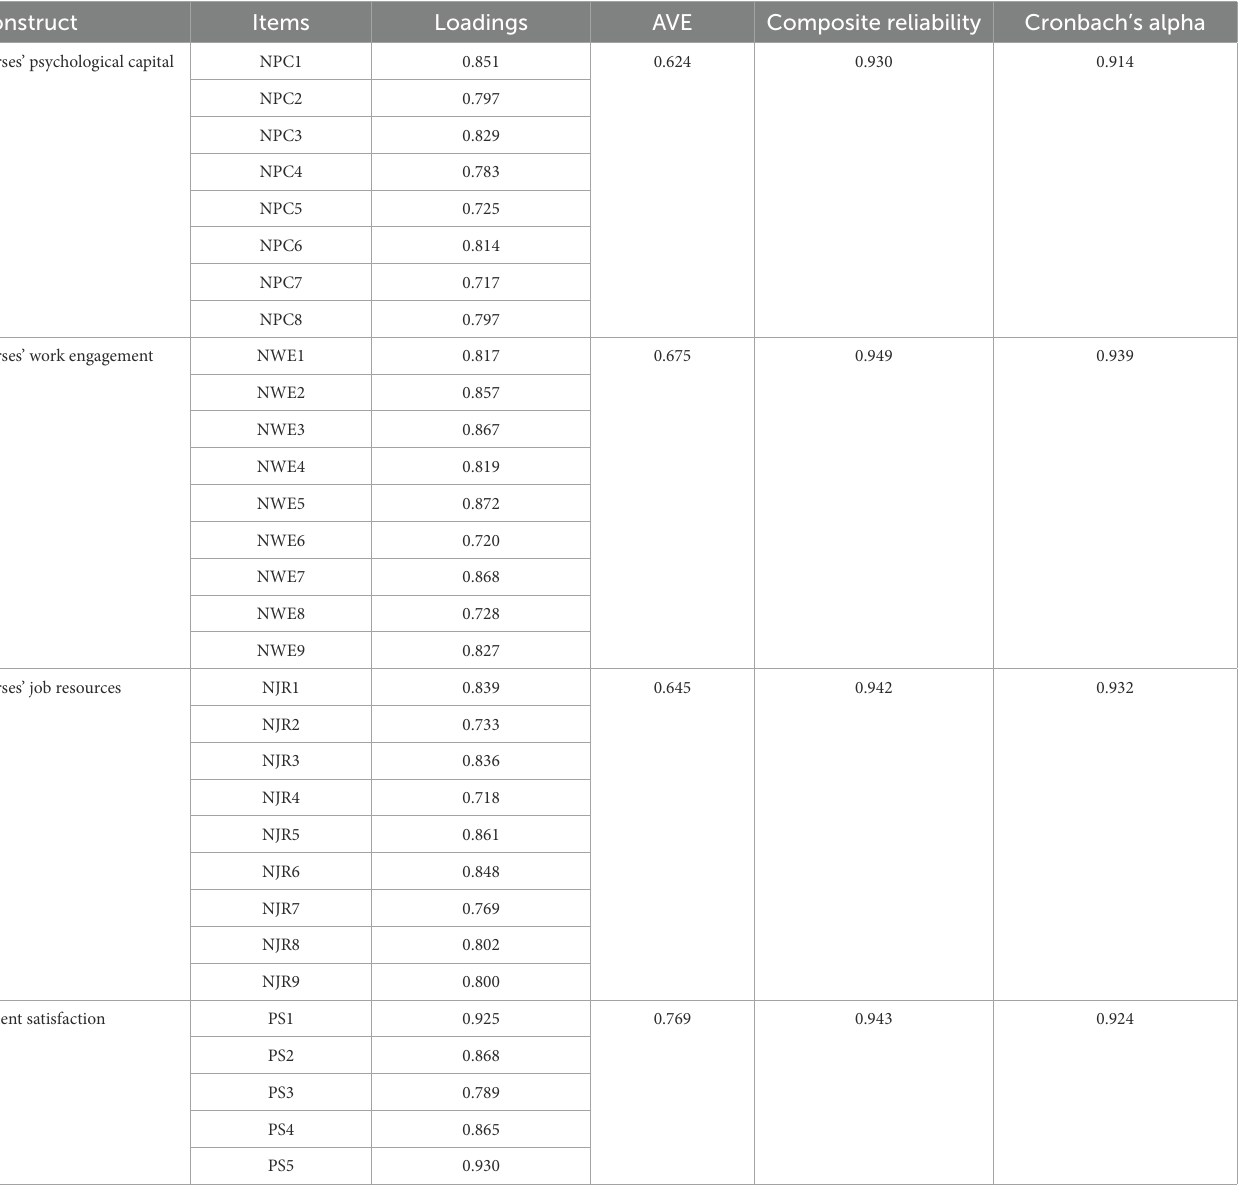
TABLE 3 The reliability and convergent validity of the constructs.